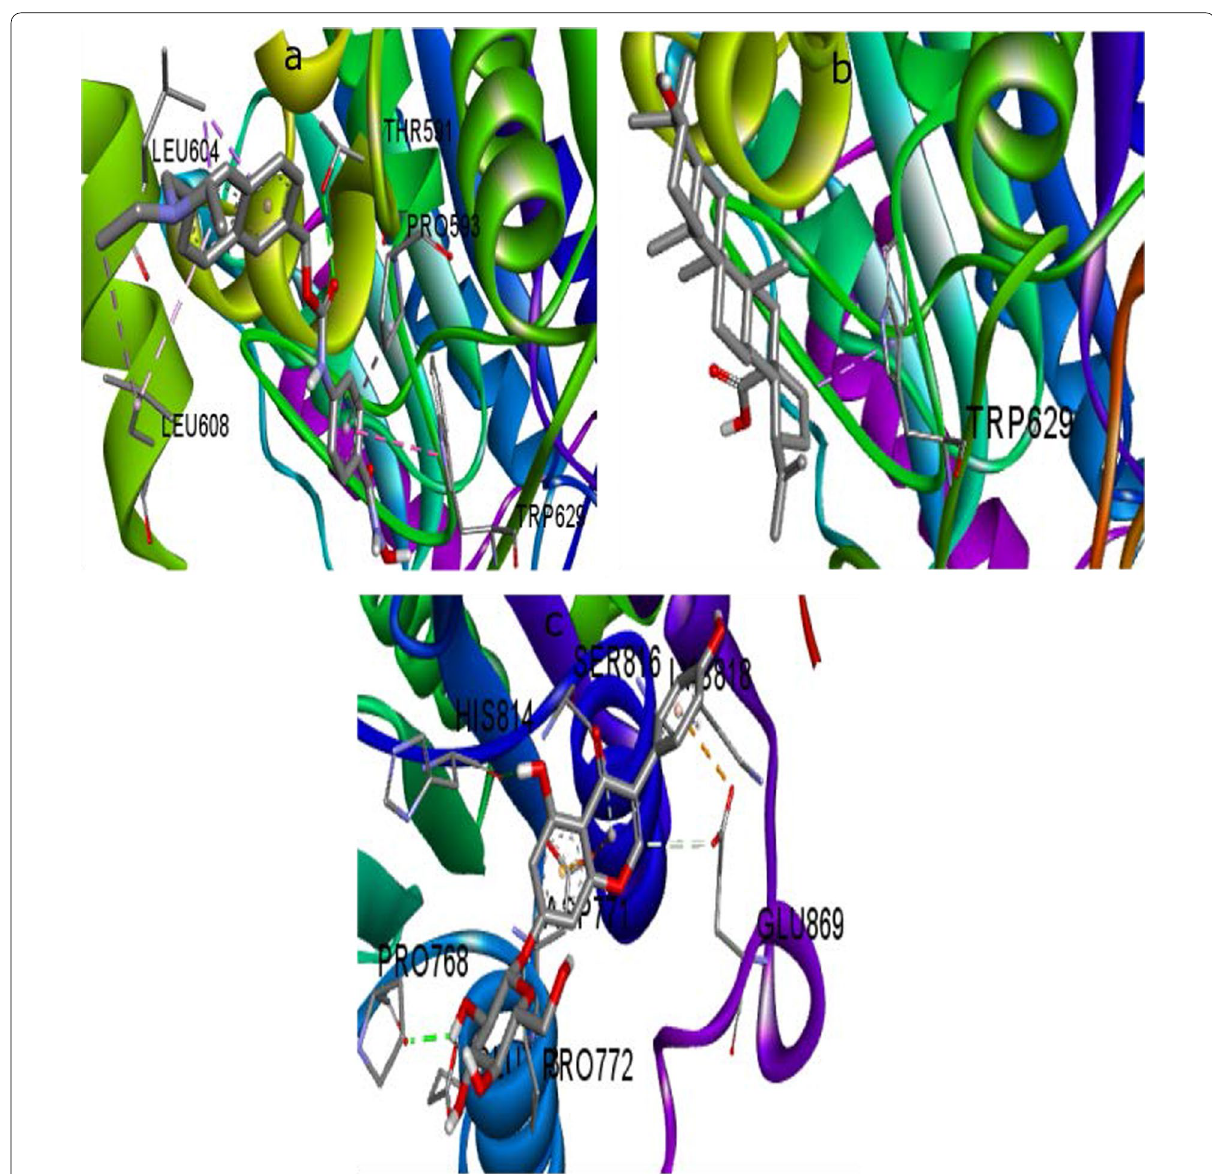
Fig. 8 3D view of the interaction between a givinostat b betulinic acid c genistin and the binding sites in histone deacetylase